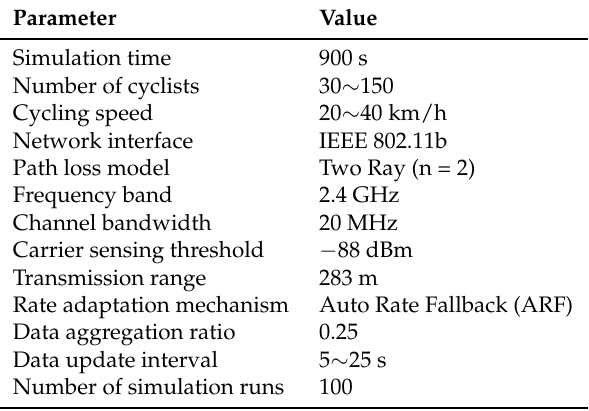
Table 2. Simulation